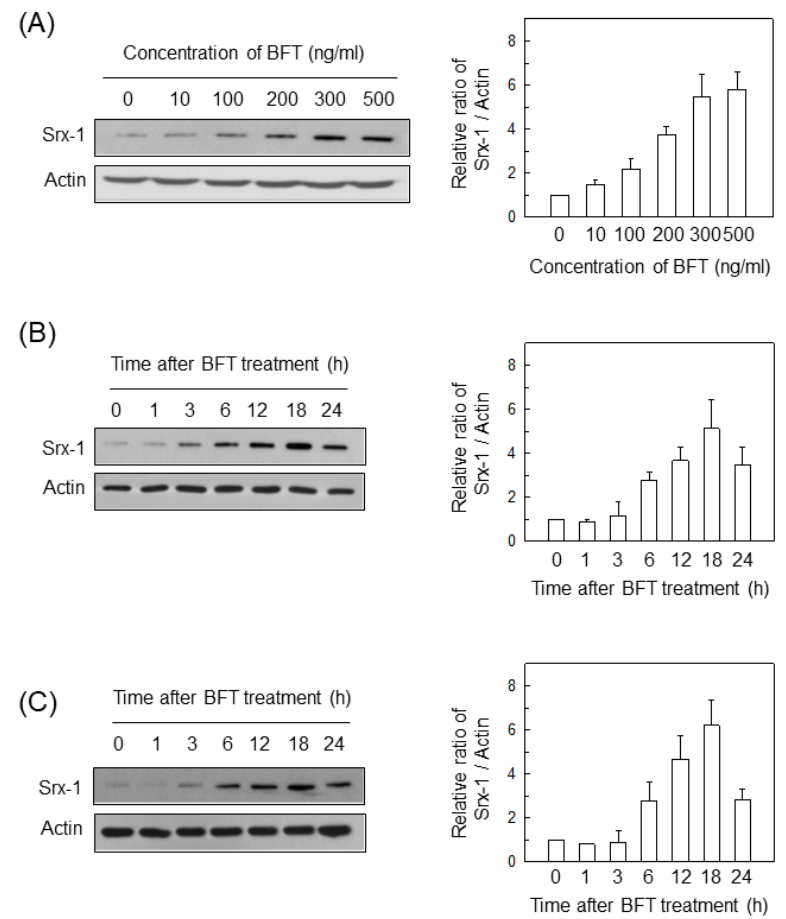
Figure 1. Expression of Srx-1 proteins in intestinal epithelial cells (IECs) treated with enterotoxin (BFT). ( A ) HCT 116 cells were treated with the indicated concentrations of BFT for 18 h. Protein expression of Srx-1 and actin was evaluated by western blot; ( B , C ) BFT (300 ng / mL) was added to HCT 116 cells ( B ) or primary intestinal CCD 841 CoN cells ( C ) for the indicated periods of time. Protein expression of Srx-1 and actin was examined by western blot. All images in ( A – C ) are representative of more than three independent experiments. Right panels show densitometric analysis for expressed proteins. Values represent the relative densities of each protein compared with actin (mean ± SD, n = 3).